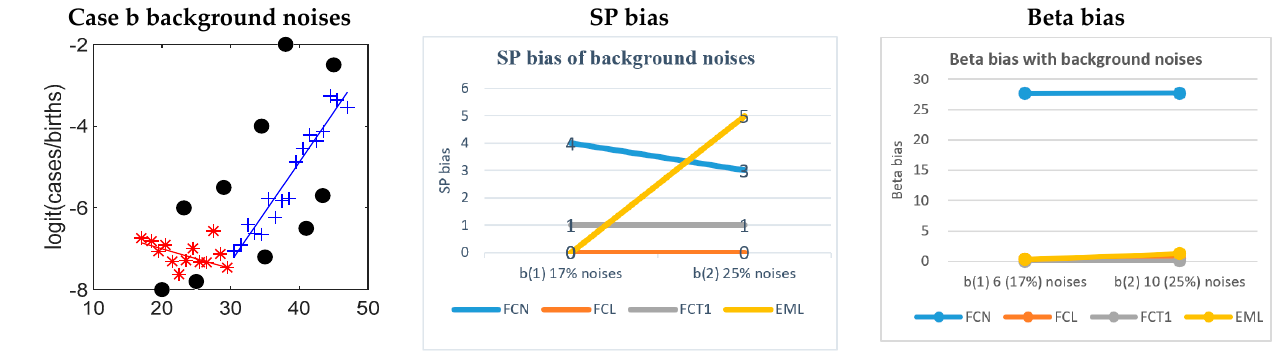
Figure 6. Comparisons of cases (a) and (b); data in case (b) are contaminated by additional background noises with cases b(1) and b(2) including 6 (17%) and 10 (25%) noises respectively.